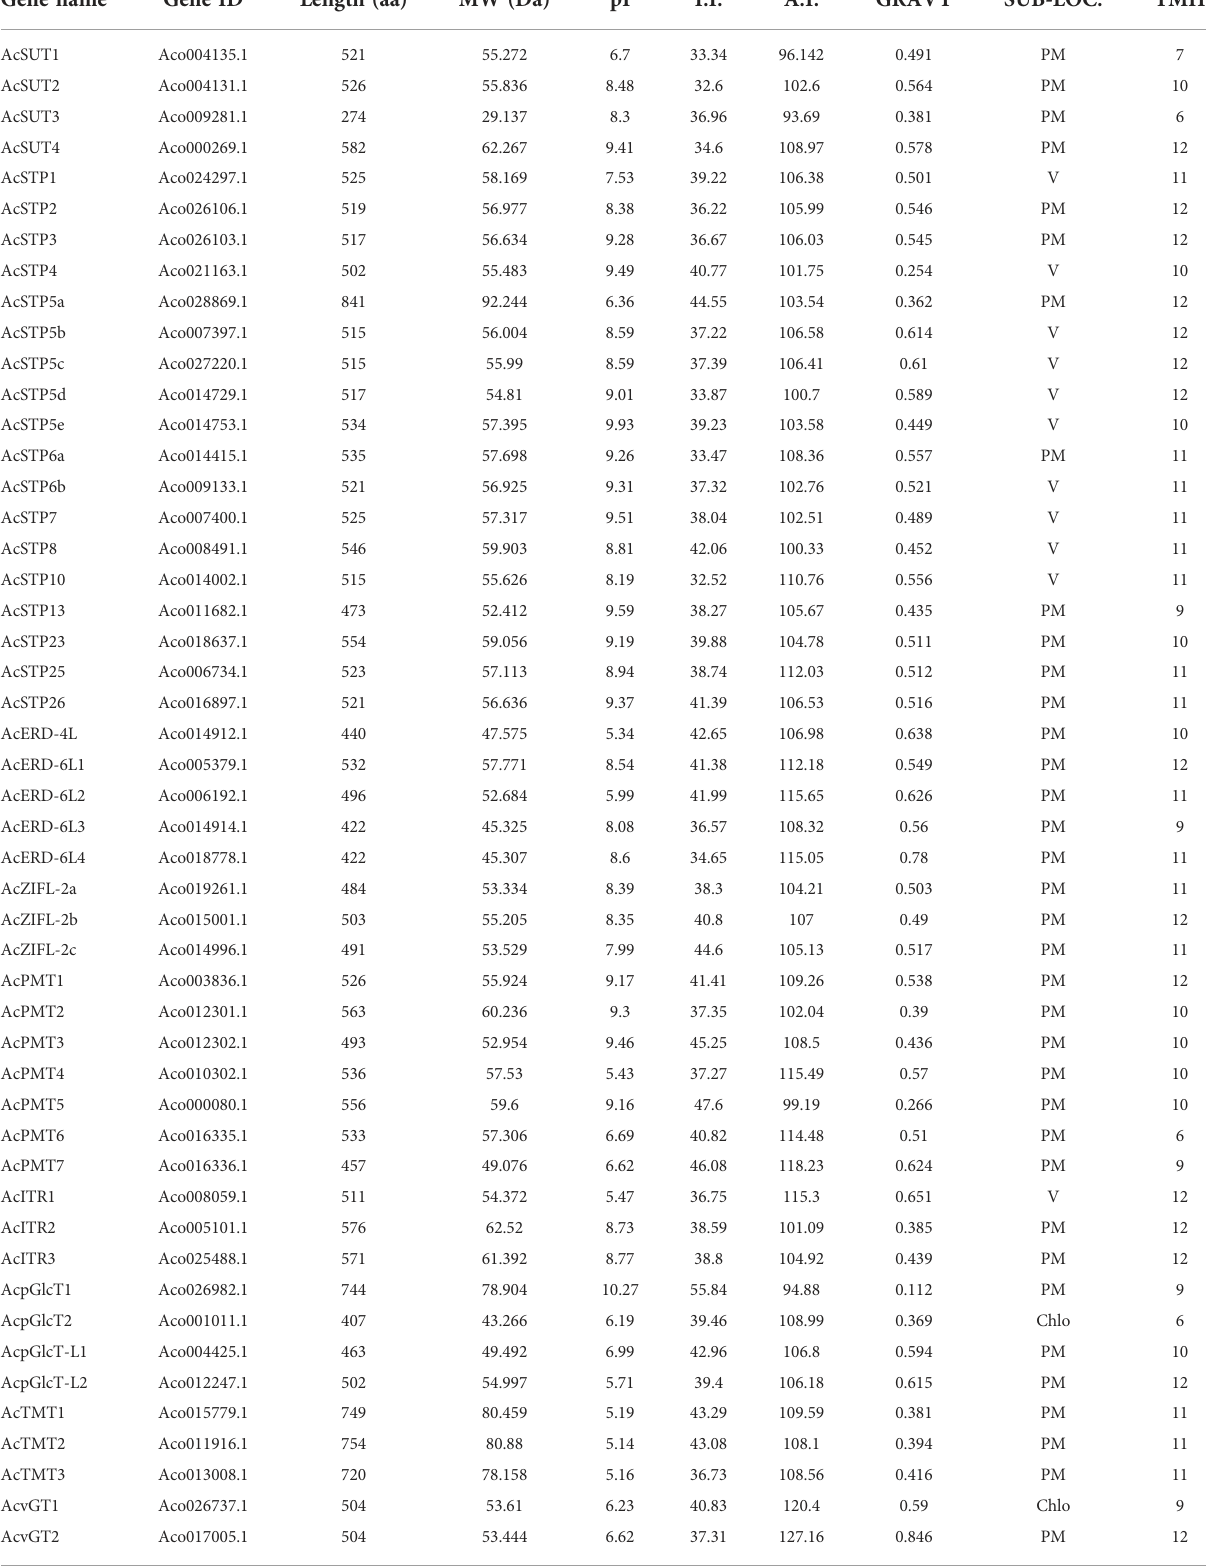
TABLE 1 Comprehensive classi fi cation and characteristics of sugar transporters identi fi ed in